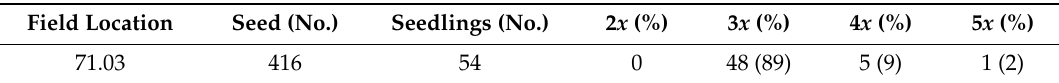
Table 5. Ploidy analysis using flow cytometry of seedlings resulting from open-pollination of field grown Acer platanoides (Norway maple) tetraploids. Seed were collected from 2016 flowering season and evaluated in 2017.